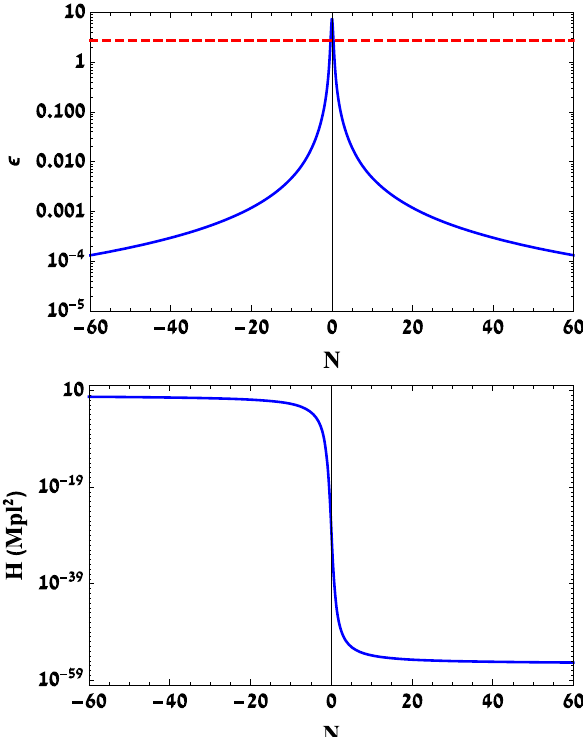
Fig. 1 Theupperpanelshowstheslow-rollparameter ε vs.thenumber of e -folds for the ansatz (1), in a logarithmic scale. The lower panel shows the corresponding Hubble function of the vacuum vs. the number of e -folds